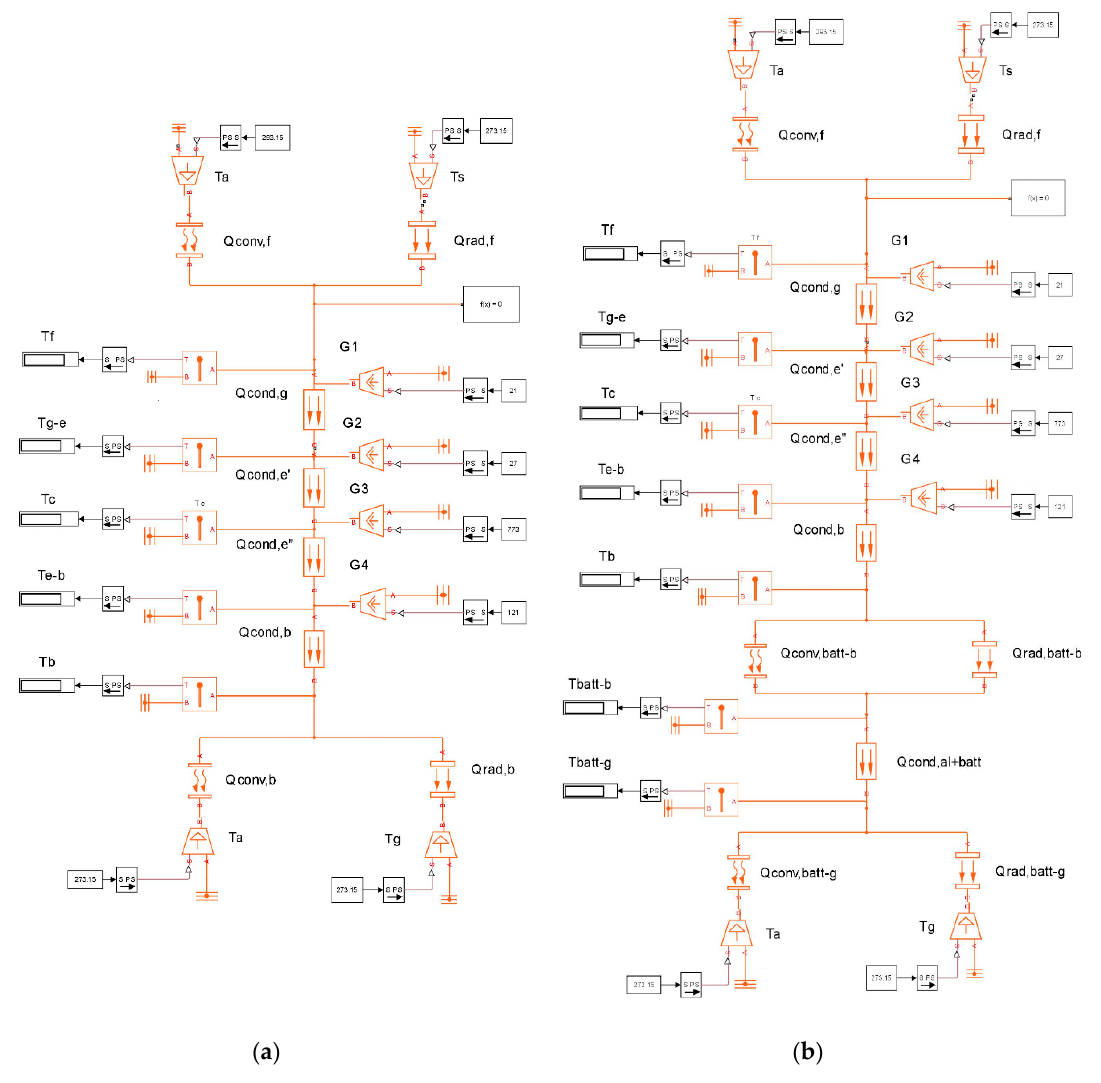
Figure 4. Simulink thermal model without ( a ) and with ( b ) battery energy storage. Figure 5. Simulink thermal model without ( a ) and with ( b ) battery energy